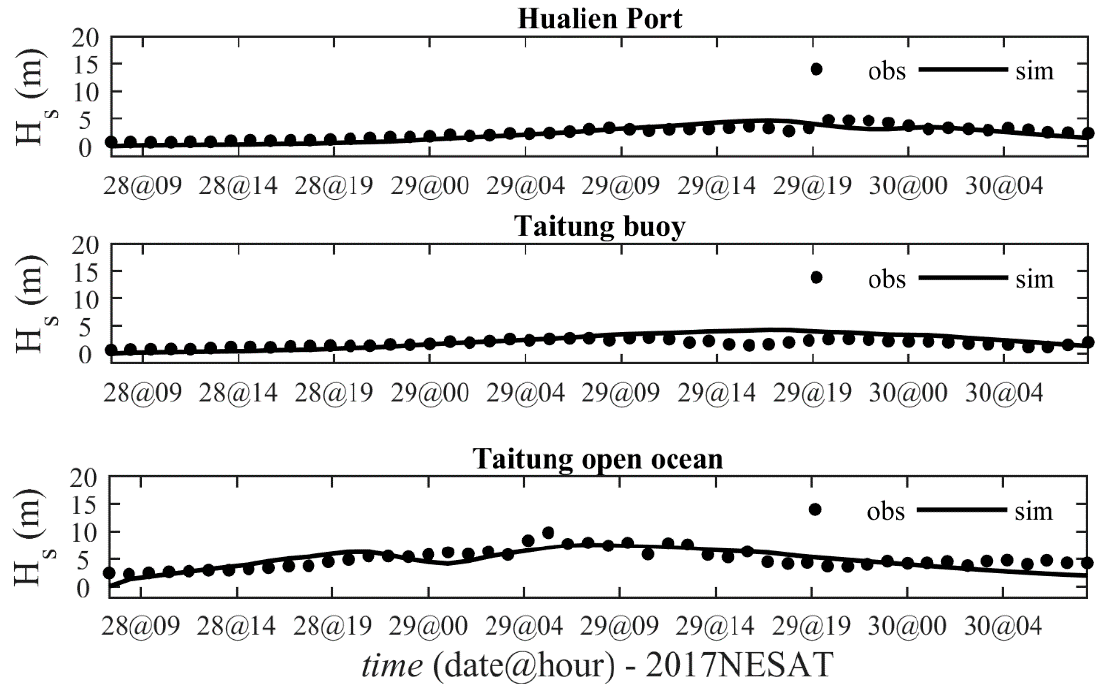
Figure 8. Comparisons of storm surges between model hindcasts and observations (Typhoon Nesat July 2017). Refer to Figure 5 for observation site locations.